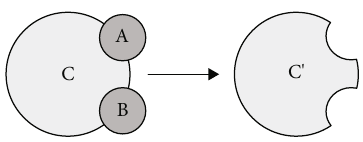
Figure 4: Containment relationship.